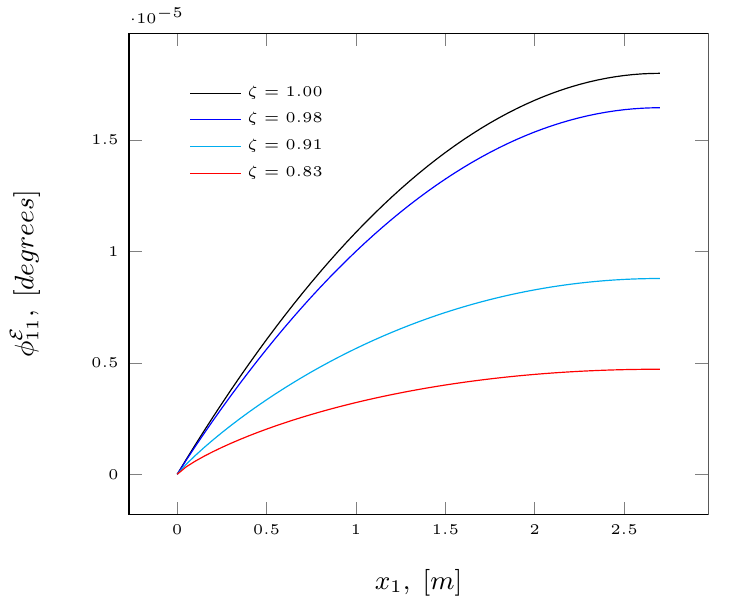
Figure 5. Slope distribution for a homogeneous beam ( ζ = 1) and fractal beams with: ζ = 0.98, ζ = 0.91 and ζ = 0.83.